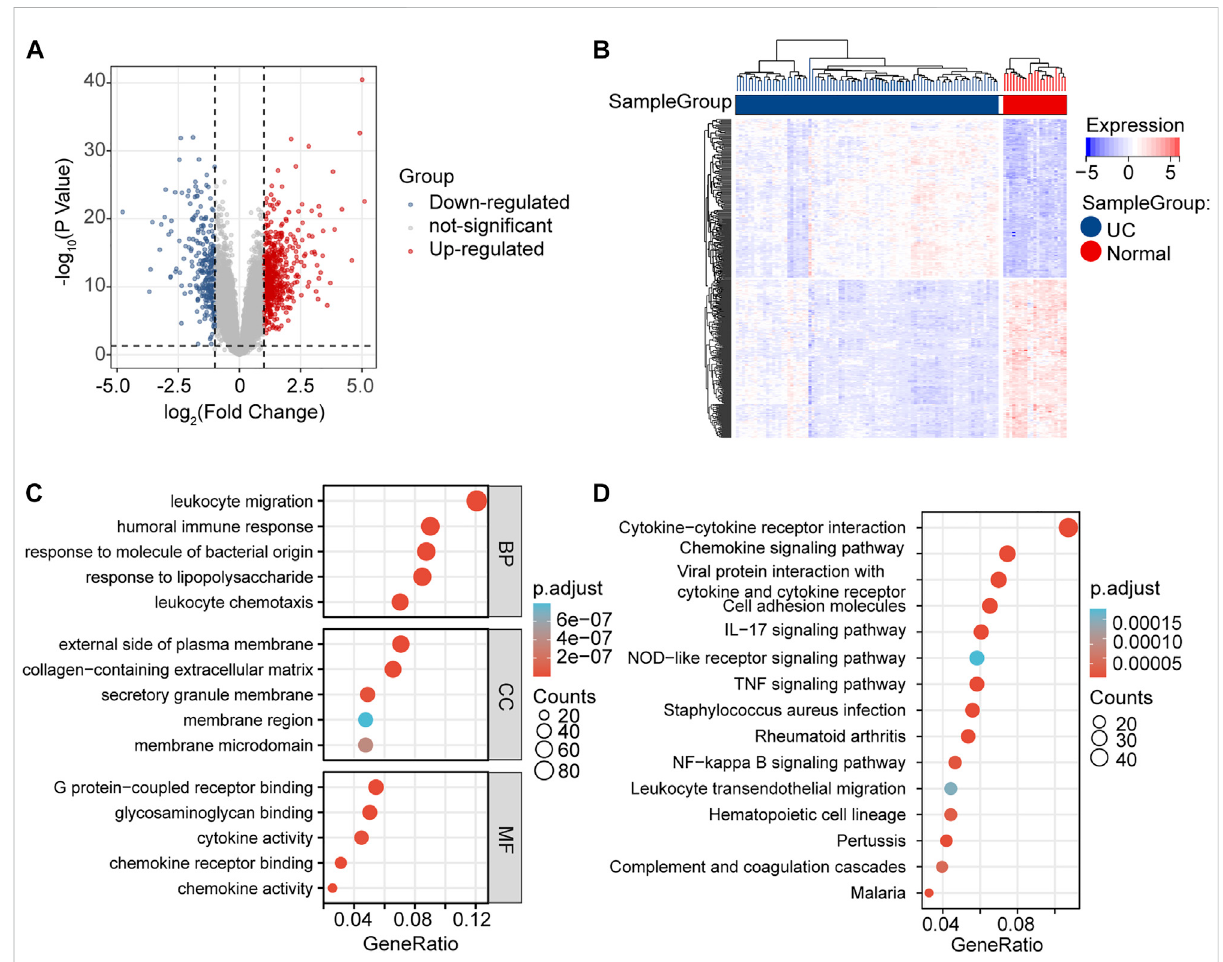
FIGURE 3 DE-mRNAs screening and enrichment analysis. (A) Volcano plots of DE-mRNAs from GSE87466. (B) Heatmap of DE-mRNAs from GSE87466. (C) BP, CC, and MF presented the top fi ve signi fi cant terms of GO enrichment analysis. (D) Top 15 signi fi cant terms of KEGG enrichment